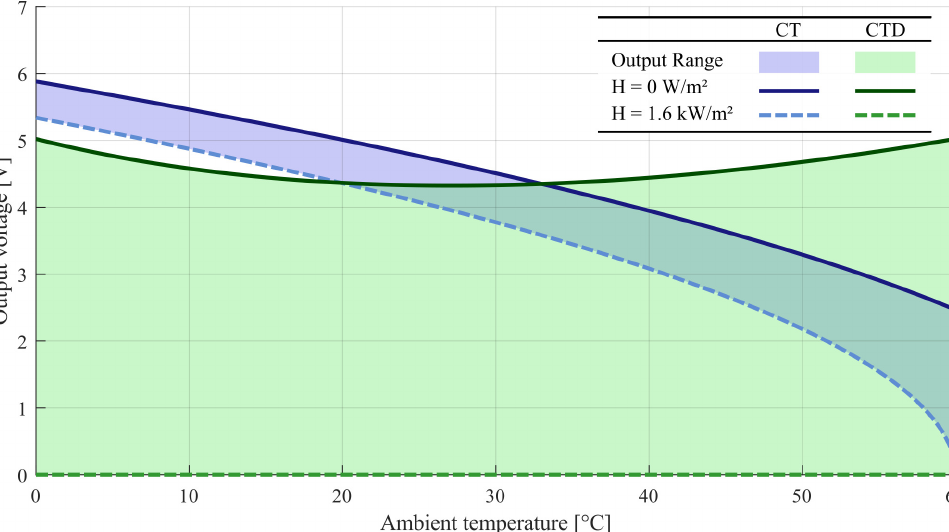
Figure 7. The output voltage response from CT and CTD